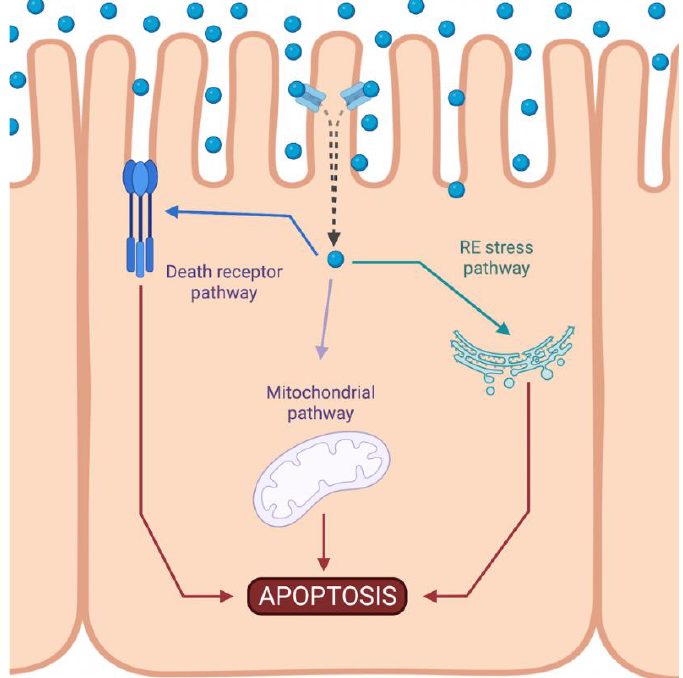
Figure 2. Activation of apoptotic pathways during cisplatin-induced nephrotoxicity. Cisplatin (blue